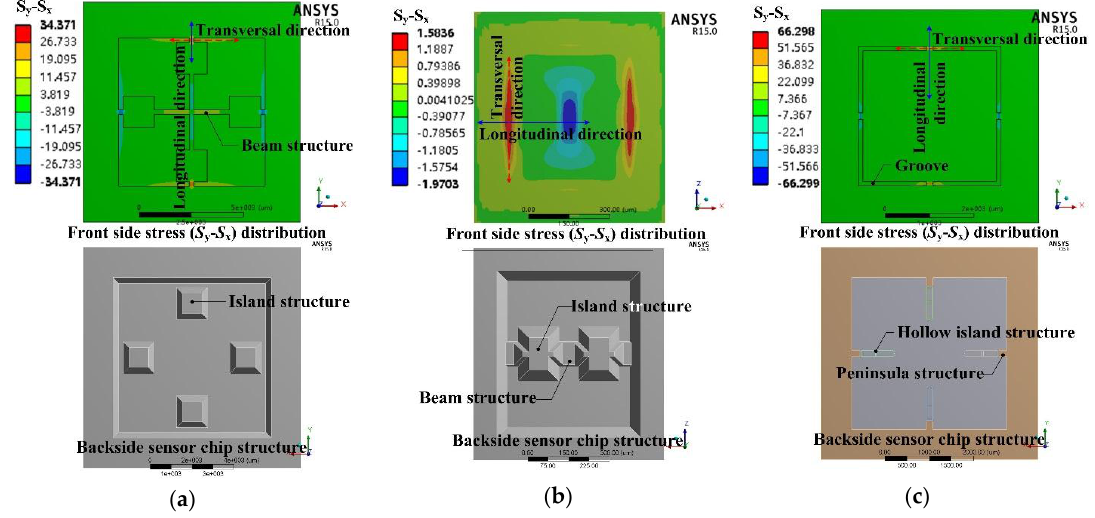
Figure 3. Diaphragm structures had both maximum bending stiffness along the transversal direction and minmum bending stiffness along the longitudinal direction: ( a ) Yu’s structure [25]; ( b ) Yang’s structure [34]; ( c ) Xu’s structure [35].